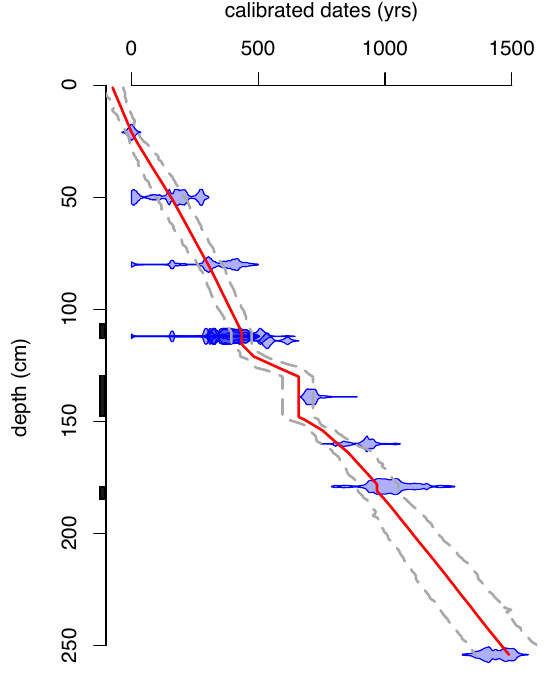
Fig. 3. Bacon age/depth model of core PA 1-08, overlaying the cal- ibrated distributions of the individual dates (blue). Dark grey ar- eas show the 95% confidence intervals of the models (Blaauw and Christen, 2011). Black rectangles along the depth scale indicate the thickness of the different tephras.